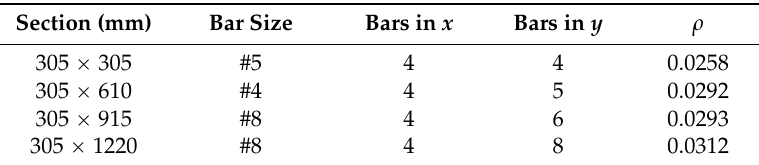
Table 13. Section geometry and longitudinal reinforcement